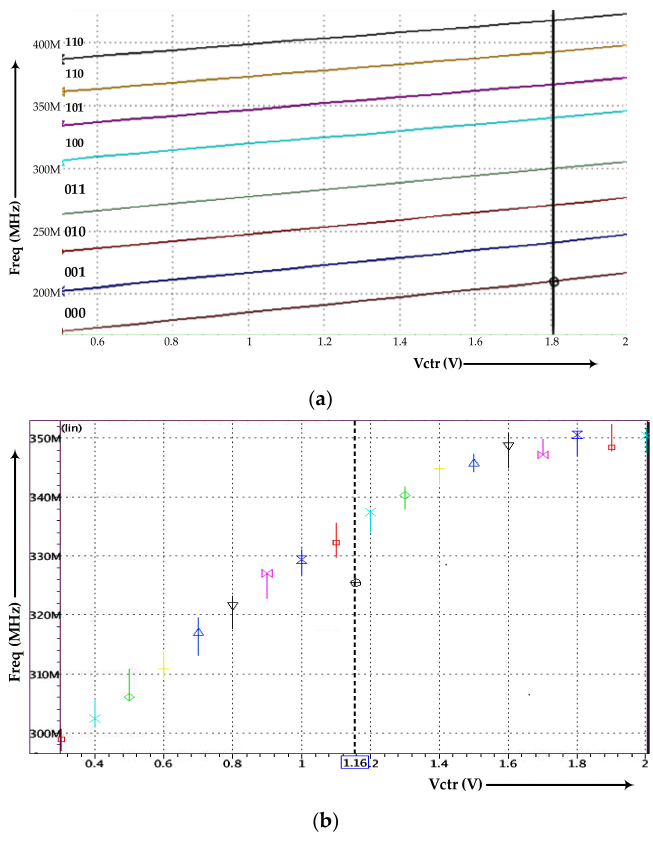
Figure 16. ( a ) VCO multiple bands; ( b ) VCO frequency vs. Vctr for 010 band.